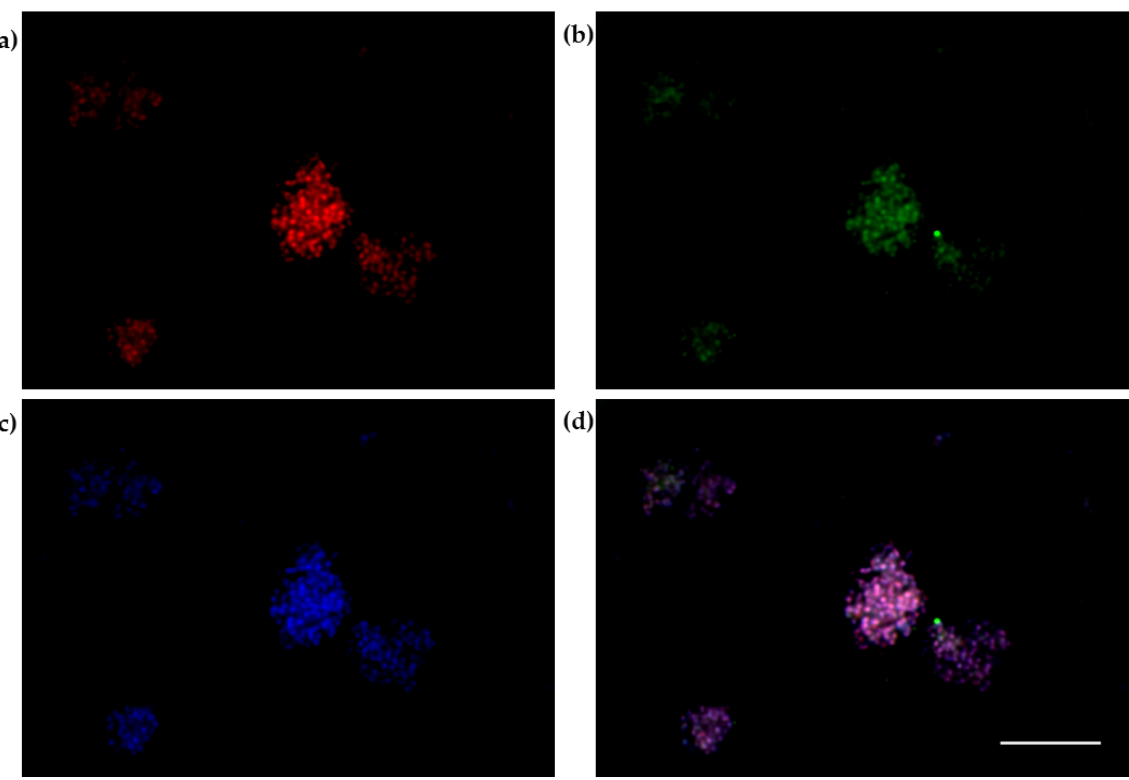
Figure 5. Annexin/PI labelling of neural spheroids treated with 1.5 mM MPP + : apoptotic cells (( a )- red); necrotic cells (( b )-green); DAPI (( c )-blue); Merge ( d ). Scale bar: 100 µm.